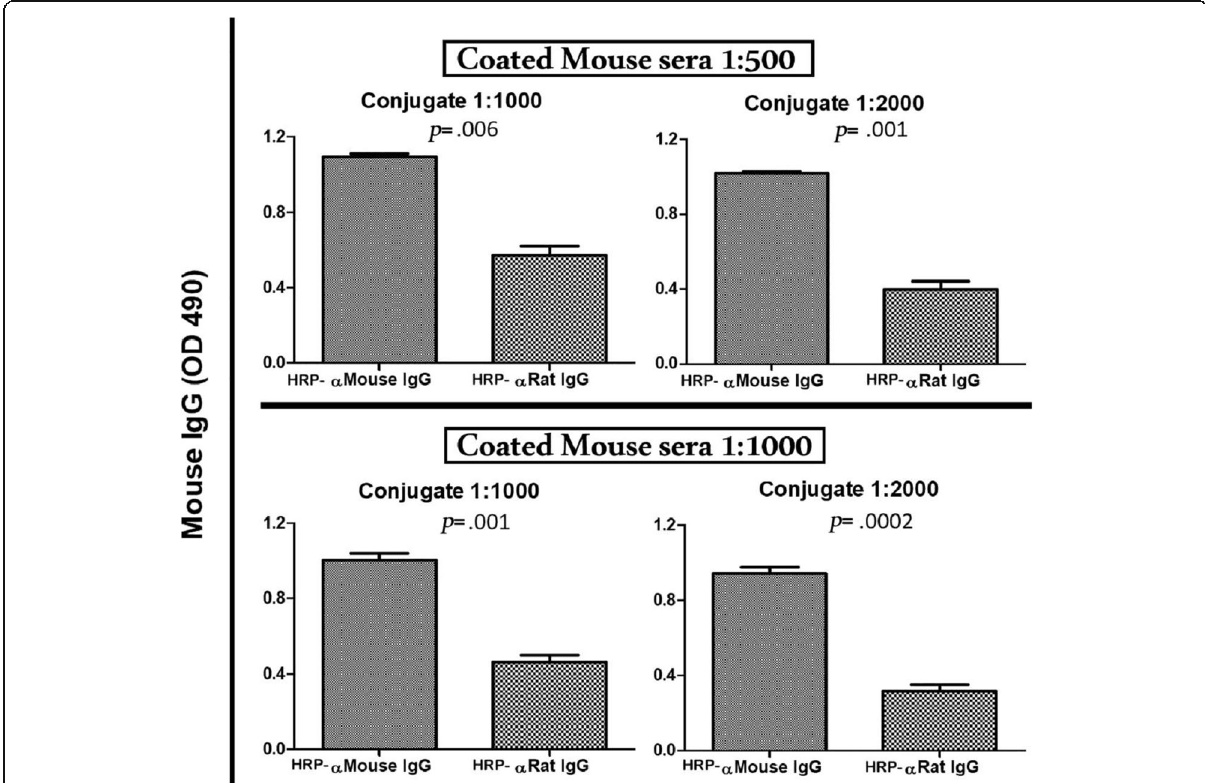
Fig. 2 Reaction between mouse serum and either HRP-conjugated anti-mouse-IgG and HRP-conjugated anti-rat-IgG: Mouse sera ( n = 5) were used at dilutions 1:500 and 1:1000 and the two conjugated antibodies were used at dilutions 1:1000 and 1:2000. Analysis of the obtained results using Students ’ t -test showed statistically significant higher reactivity of the homologous antibody compared to a much less reactivity to the heterologous HRP-anti-rat-IgG antibody. The background cross-reaction of heterologous antibody further dropped upon increasing sera and conjugate dilutions (reaction with both homologous and heterologous antibodies were 0.9414±0.14 and 0.317 ±0.141, respectively ( p= .0002) with a Δ mean O.D. of